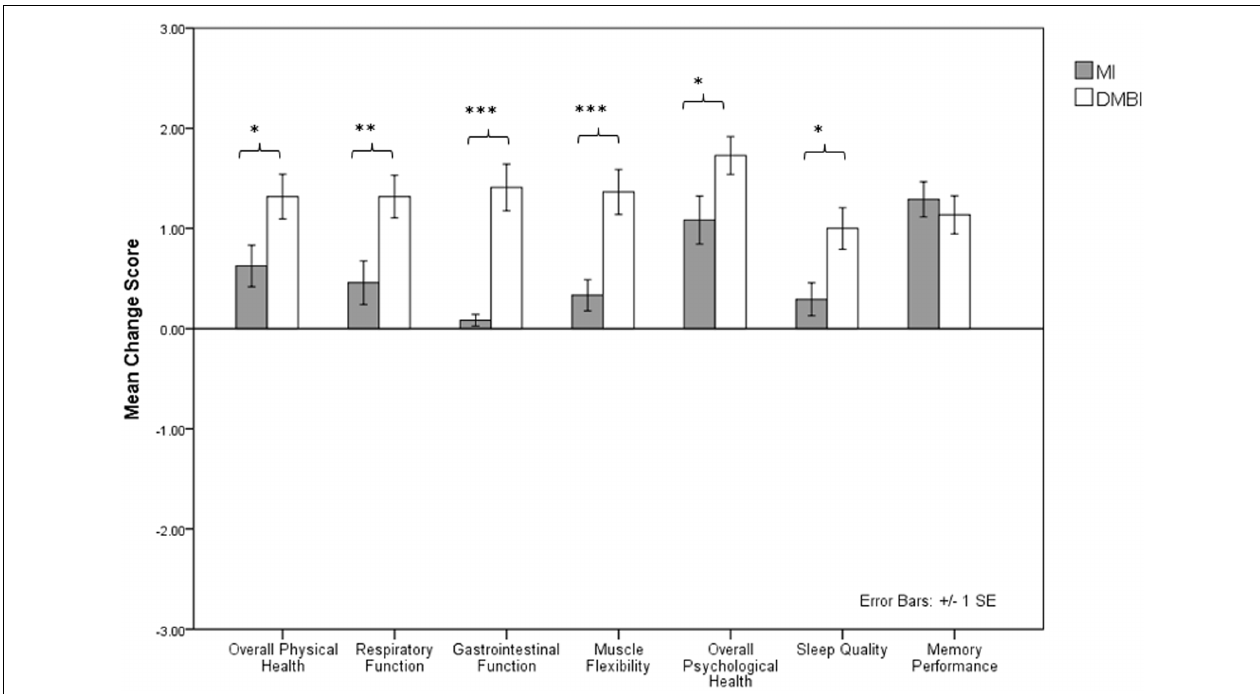
FIGURE 1 | Mean improvement score of seven indices indicating changes in subjective physical and psychological health and memory performance (i.e., Overall Physical Health, Respiratory Function, Gastrointestinal Function, Muscle Flexibility, Overall Psychological Health, Sleep Quality, and Memory Performance) in the Memory Intervention (MI; n = 24) and Dejian Mind-Body Intervention (DMBI; n = 22) groups. ∗ p < 0.05, ∗∗ p < 0.01, ∗∗∗ p <